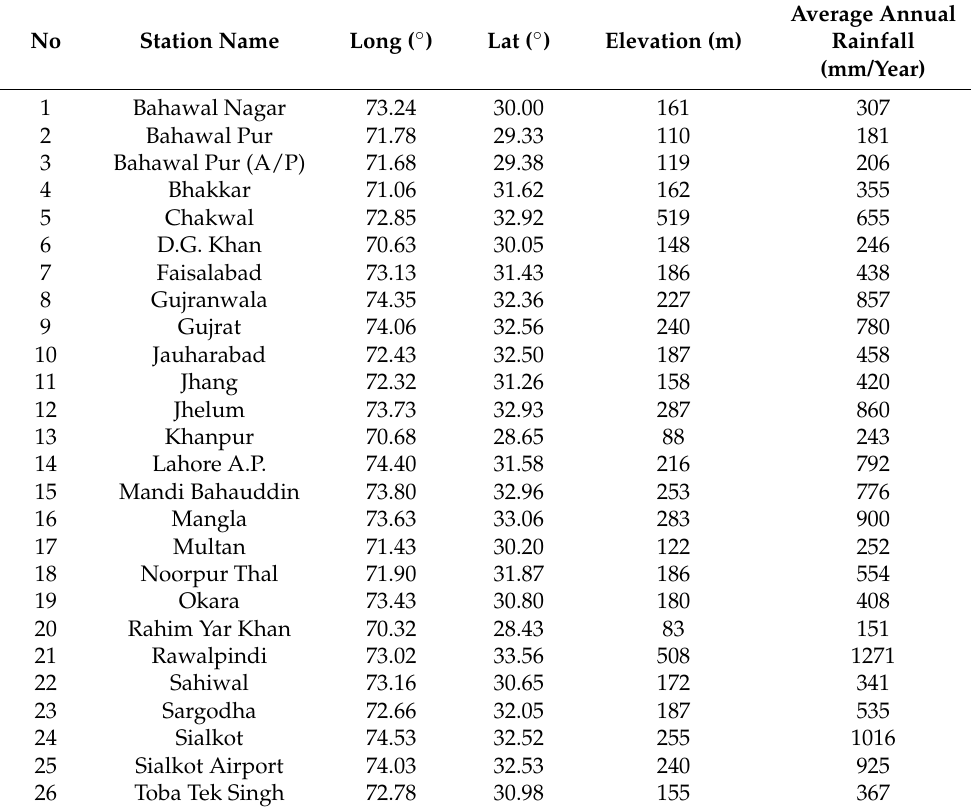
Table A1. Salient attributes of the considered weather stations.